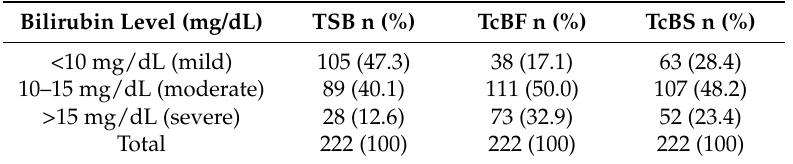
Table 1. Distribution of bilirubin levels based on severity of jaundice using total serum bilirubin (TSB) or transcutaneous bilirubin (TcB).